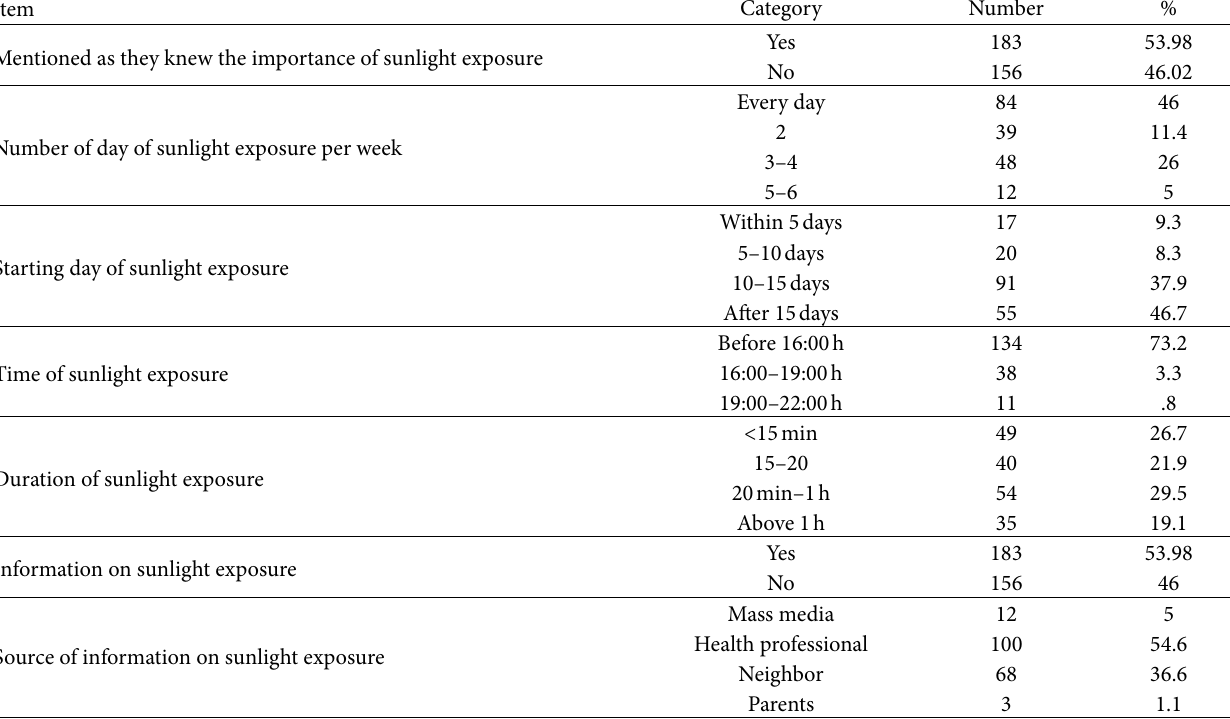
Table 3: Knowledge of respondents on sunlight exposure of infant in Farta district, Northwest Ethiopia, 2018.